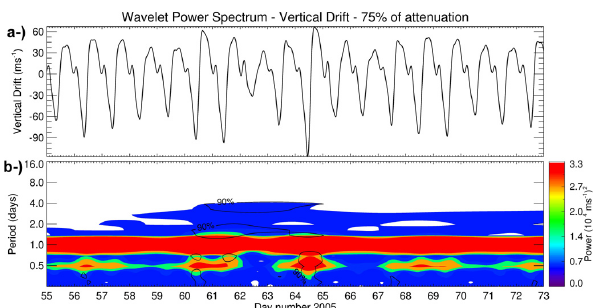
Fig. 5. (a) vertical drifts calculated by the CODB model consid- ering the case where the UFK wave propagated upwards with no exponential growth of amplitude. (b) wavelet power